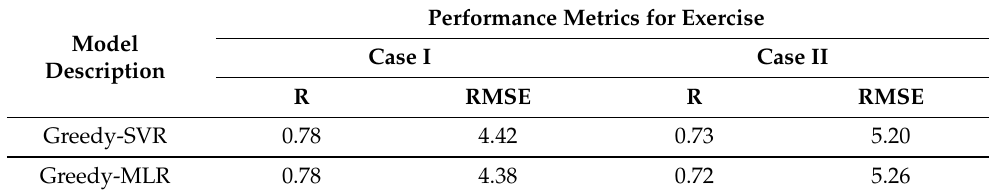
Table 8. Models performance metrics for Case I and II during exercise.